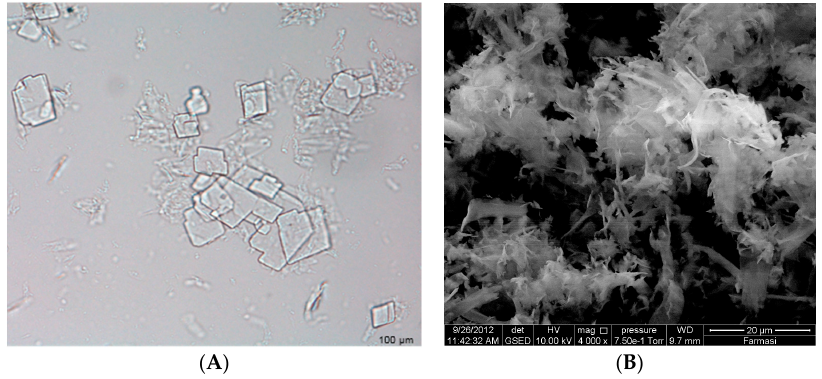
Figure 1. Insoluble drug crystals of S1 formulation (40 mg) observed under optical microscope ( A ) and Environmental Scanning Electron Microscope (eSEM) ( B ).